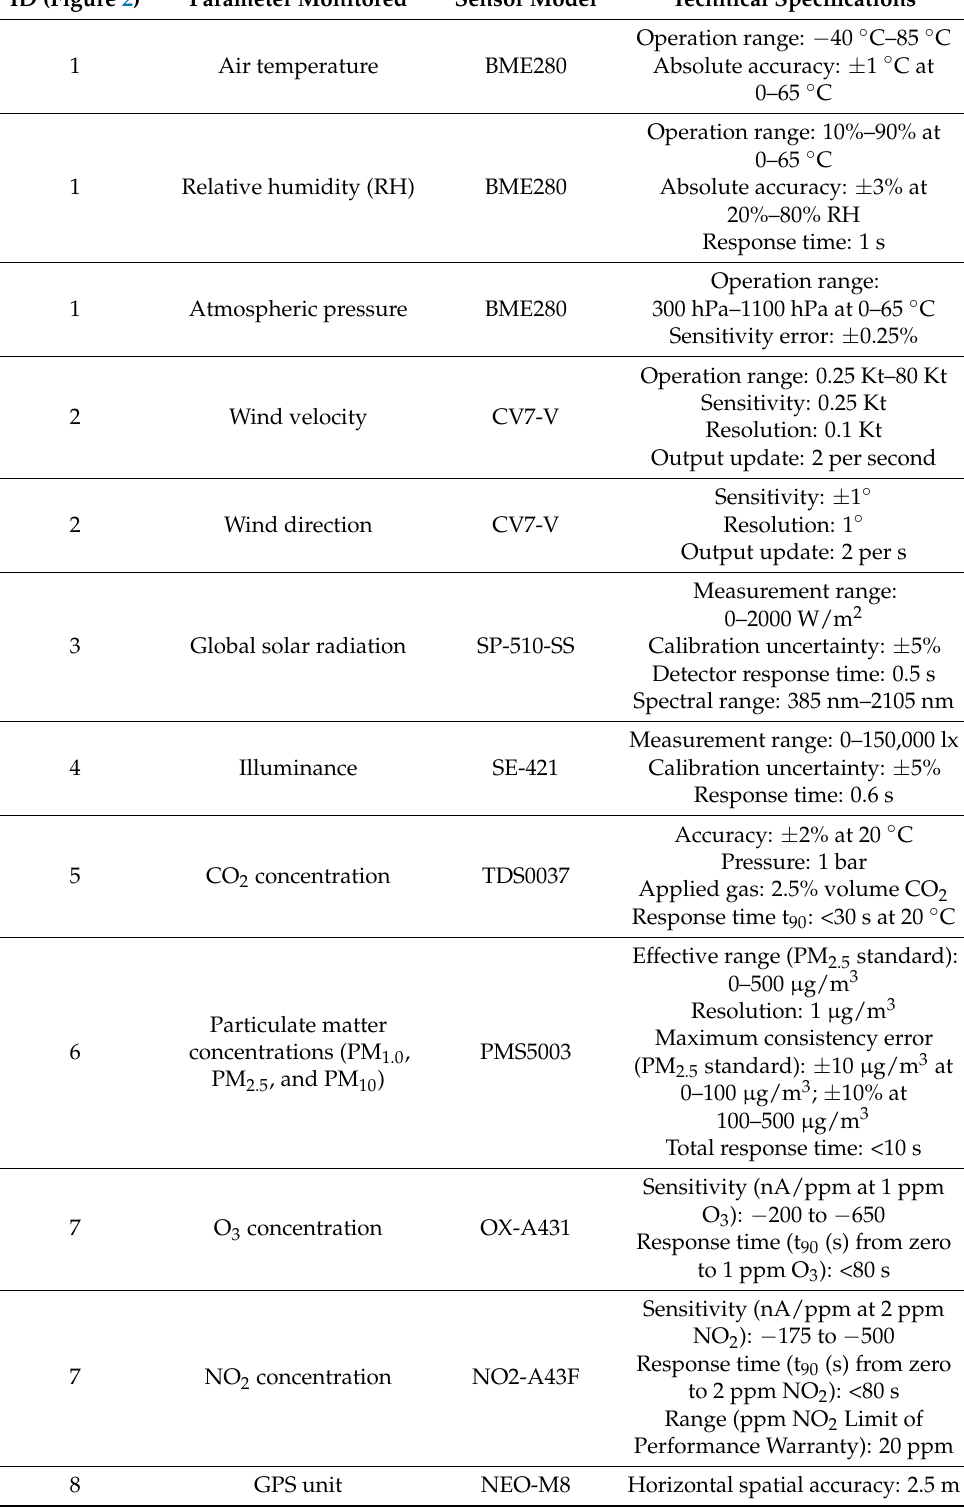
Table 1. Technical specifications of each sensor in the new wearable monitoring